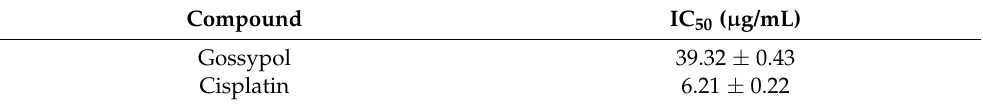
Table 2. Cytotoxic effect of gossypol and cisplatin on human gastric epithelial (GES-1) cells.